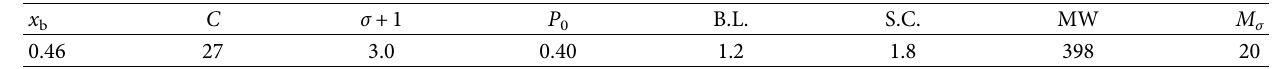
Table 2: Molecular structural parameter of JC anthracite coal sample.